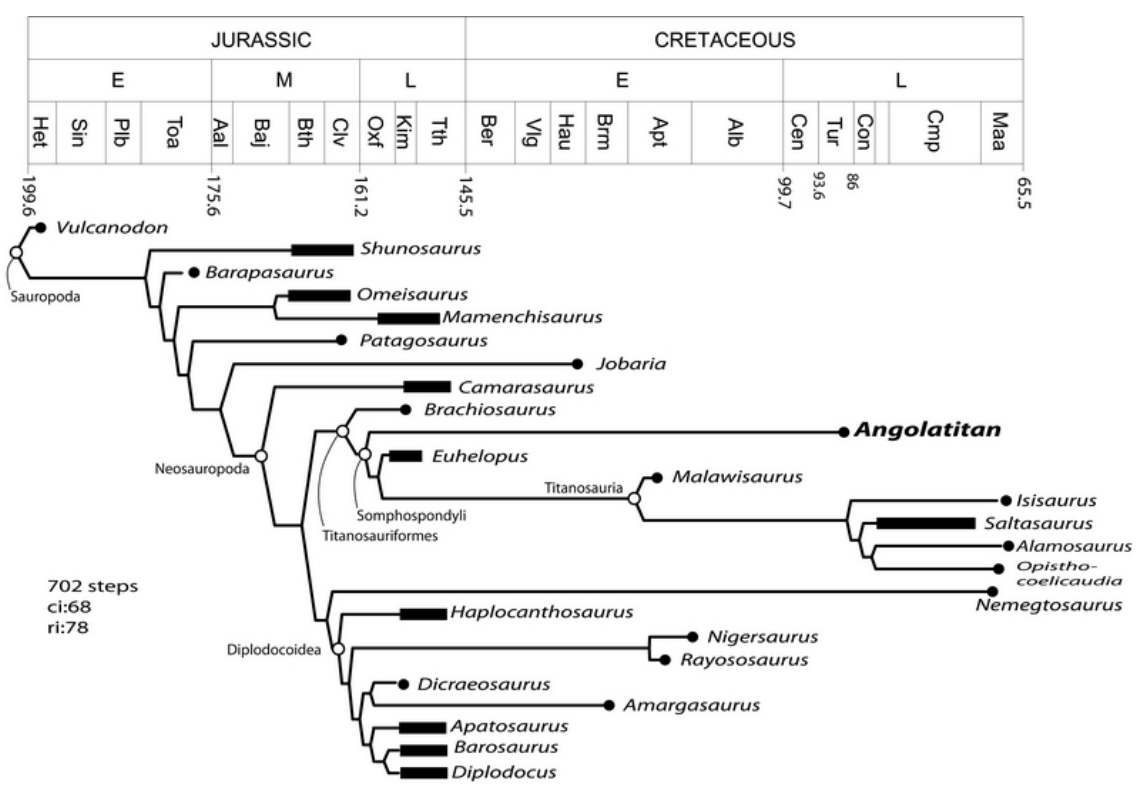
Fig. 6 – Phylogenetic relationships of Angolatitan adamastor and other sauropods. See text for